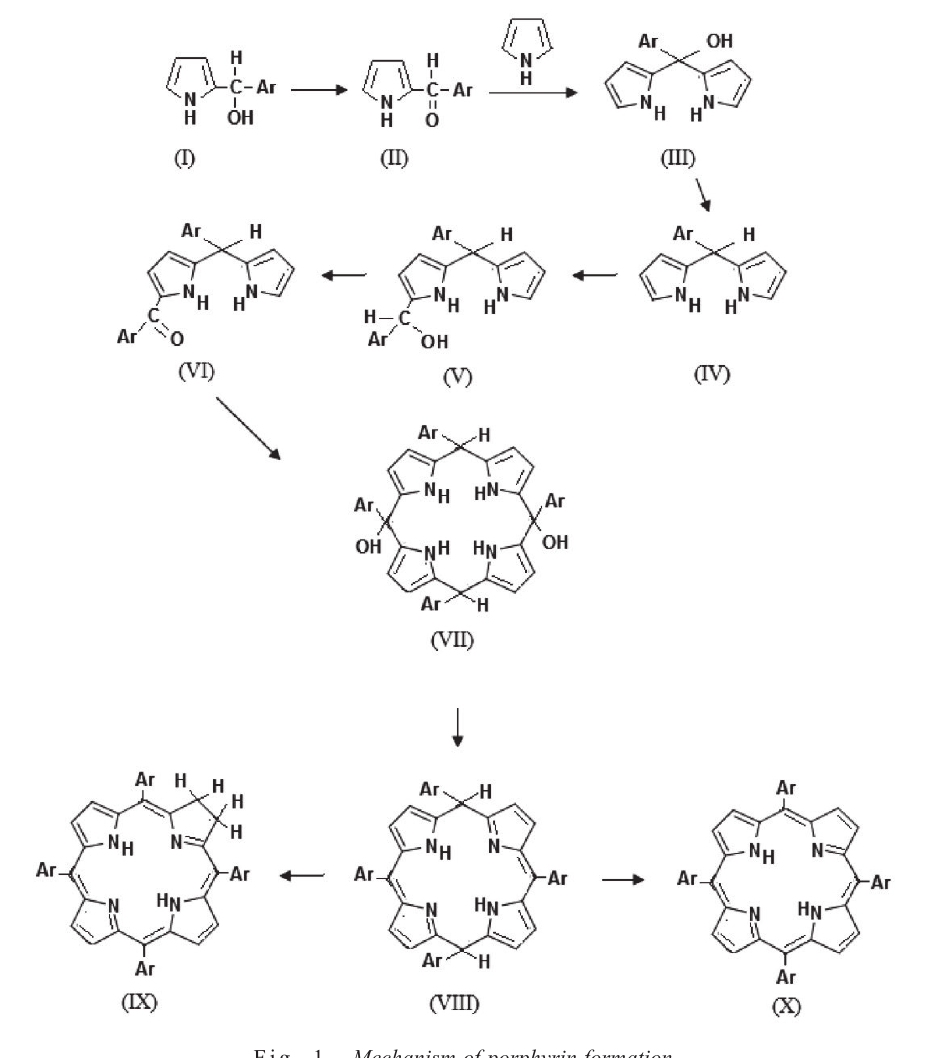
Fig. 1 – Mechanism of porphyrin formation